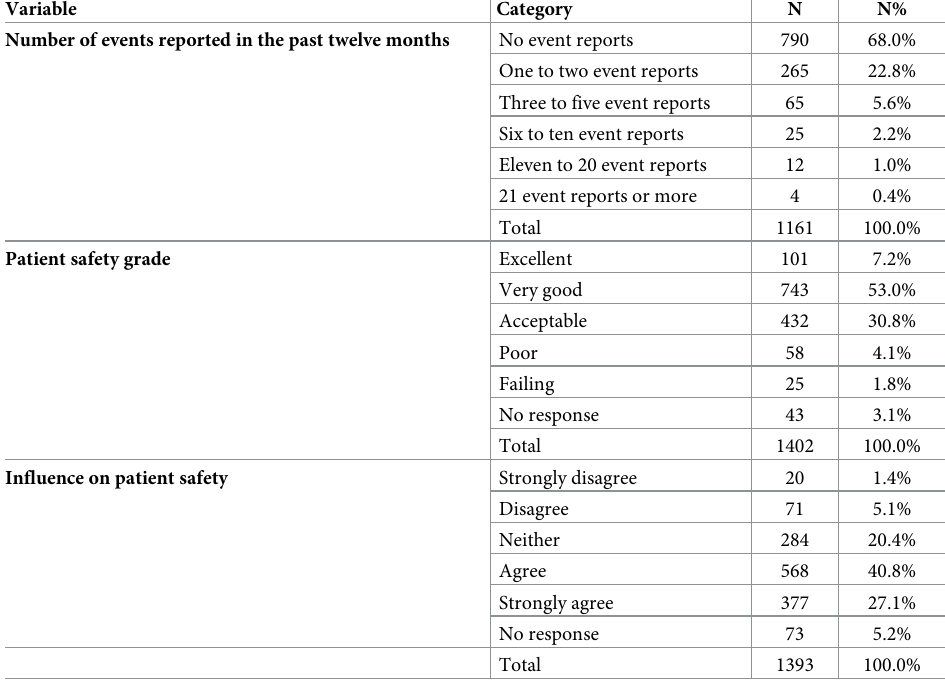
N–Absolute frequencies, N%–Relative